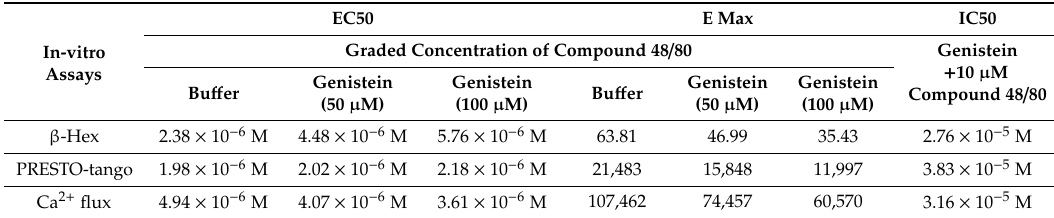
Table 1. The e ff ect of Genistein on the EC50 and maximal response (Emax) of compound 48 / 80 and IC50 of Genistein via di ff erent in-vitro assays. For the EC50 and Emax, estimation cells were treated with bu ff er or Genistein (50 µ M and 100 µ M) followed by graded concentrations of compound 48 / 80. For IC50 estimation, cells were treated with graded concentrations of Genistein followed by 10 µ M of compound 48 /